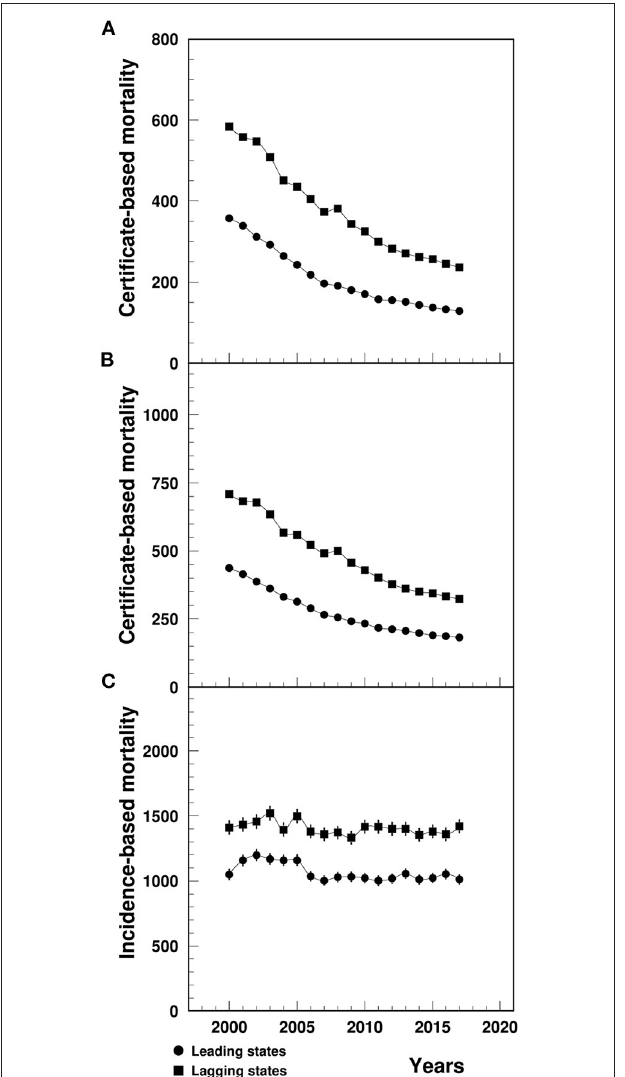
FIGURE 1 | Temporal trend of CBM-UCD (A) , CBM-MCD (B) and IBM (C) (1/100,000) of MI among patients aged 65 + in the U.S. leading and lagging states. CBM-UCD, Certificate-based mortality from MI as underlying cause of death, CBM-MCD, Certificate-based mortality from MI as the multiple cause of death, IBM, Incidence-based mortality, MI, Myocardial infarction. Note: 1 Data for (A,B) were derived from CDC WONDER, and data for (C) were derived from 5% Medicare Beneficiaries. The 95%CI were too small to show up in the CBM plots (A,B) .